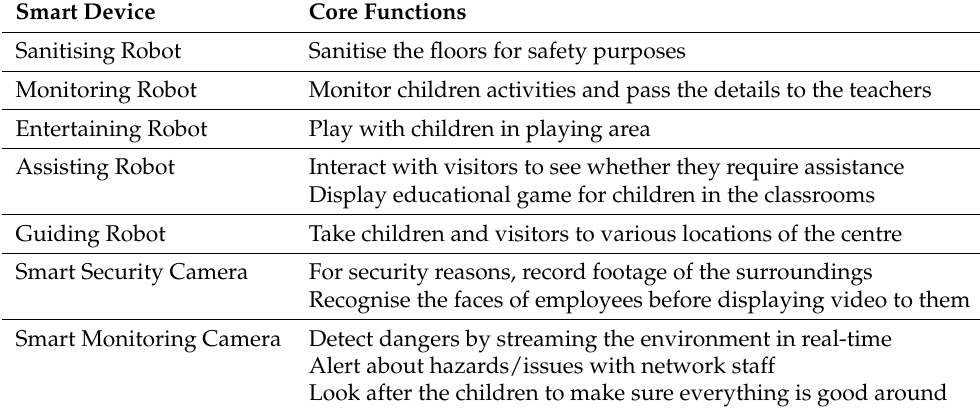
Table 7. Core functions of smart devices in early learning